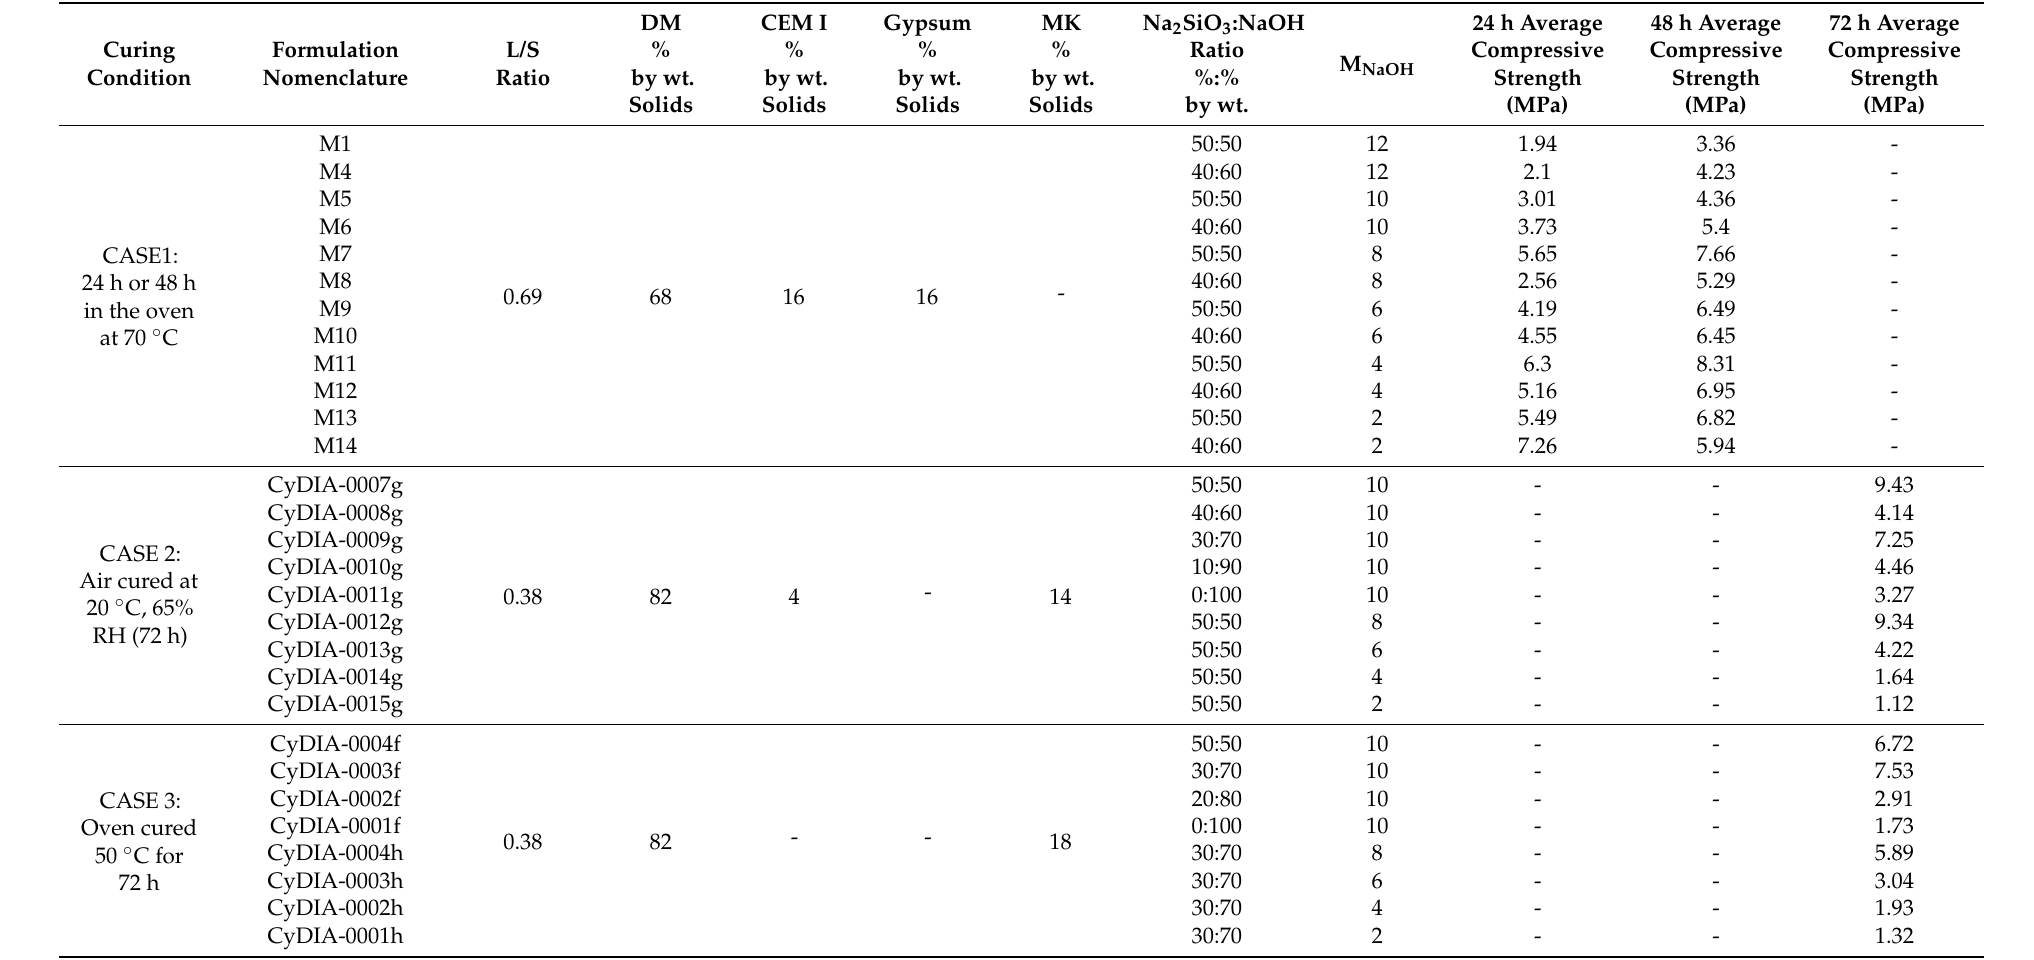
Table 3. Mix proportions and properties of the developed formulations used in the experimental